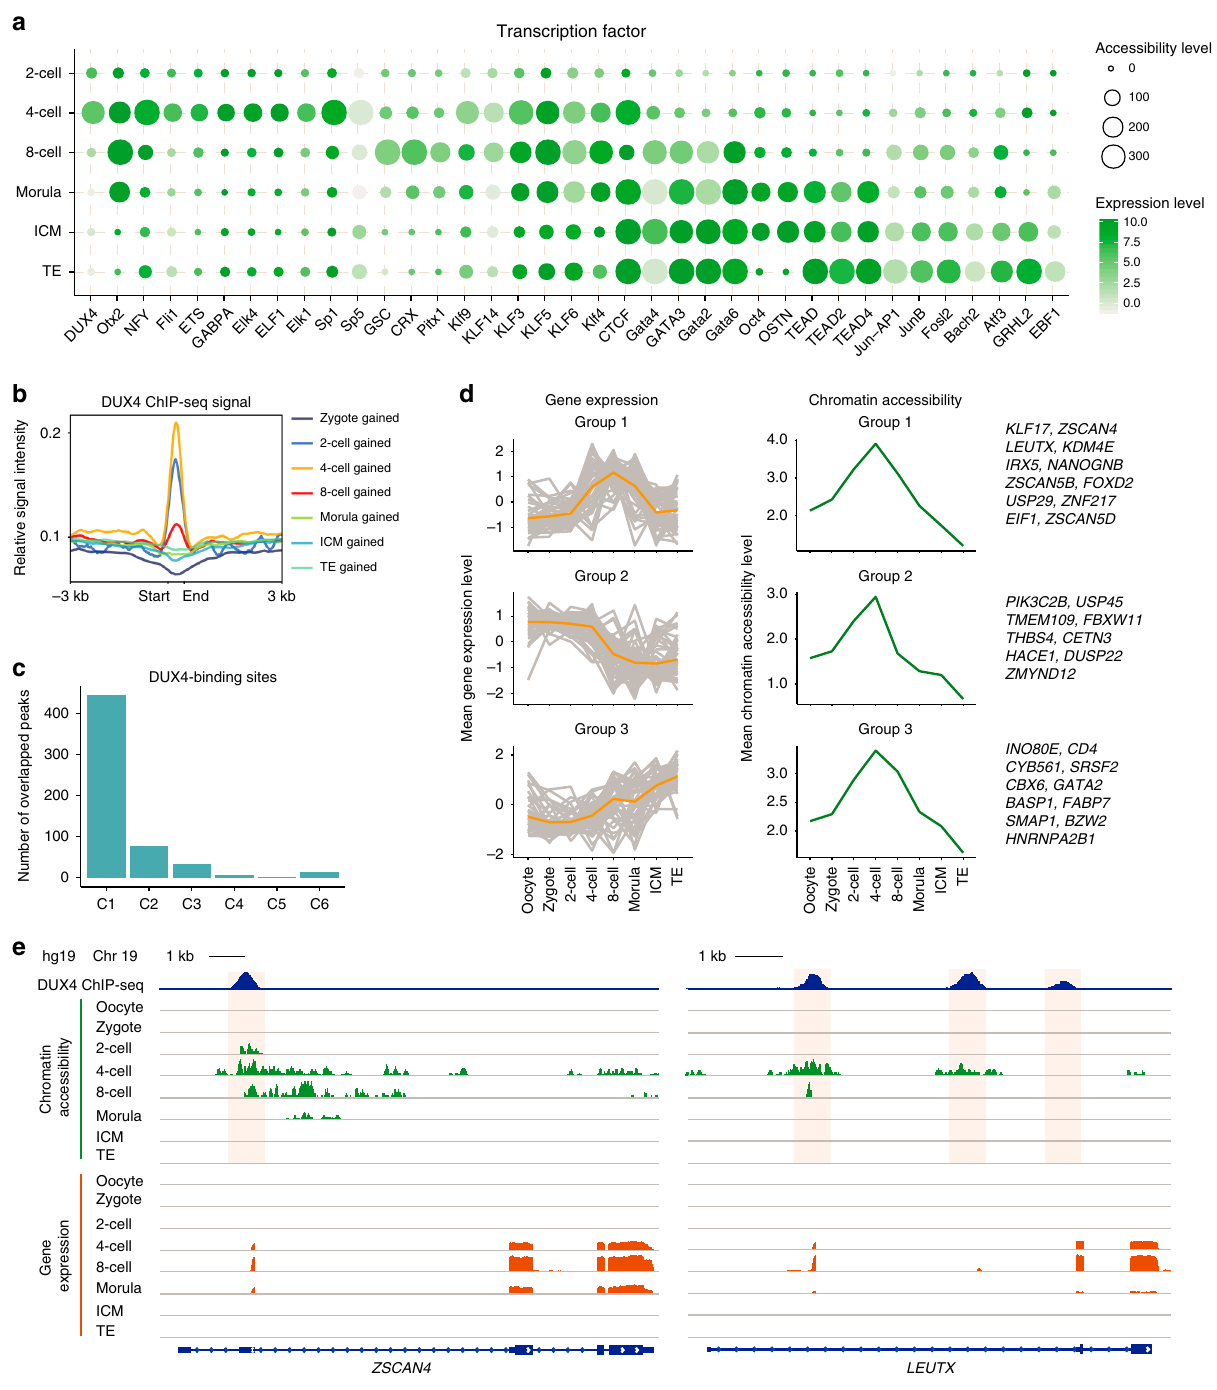
Fig. 3 Identi fi cation of key transcription factors during human pre-implantation development. a Enrichment of TF motifs within the gained accessible regions at the indicated stages. Each point represents a signi fi cant enrichment for the indicated motifs. The point size represents the motif-enrichment P value ( − log P value) and the color represents gene expression level of the corresponding TFs. OSTN represents OCT4-SOX2-TCF-NANOG, and the expression level for OSTN is the mean expression level of the four genes. b Enrichment of DUX4 ChIP-seq signals in accessible regions gained at each development stage. c Number of DUX4-binding sites that overlap with the accessible regions in the six chromatin accessibility clusters in Fig. 2a. d Left panel: fuzzy clustering analysis of DUX4 target gene expression level at the indicated stages. The individual gray lines represent the expression level of individual genes, and the orange line represents the value for the cluster center. Middle panel: dynamics of mean values of normalized chromatin accessibility signals for all regions corresponding to the genes analyzed in the left panel. The example genes are listed in the right panel. e Genome browser views showing DUX4 binding, chromatin accessibility, and gene expression signal around ZSCAN4 (left panel) and LEUTX (right panel). Source data used in this fi gure are provided as Supplementary Data